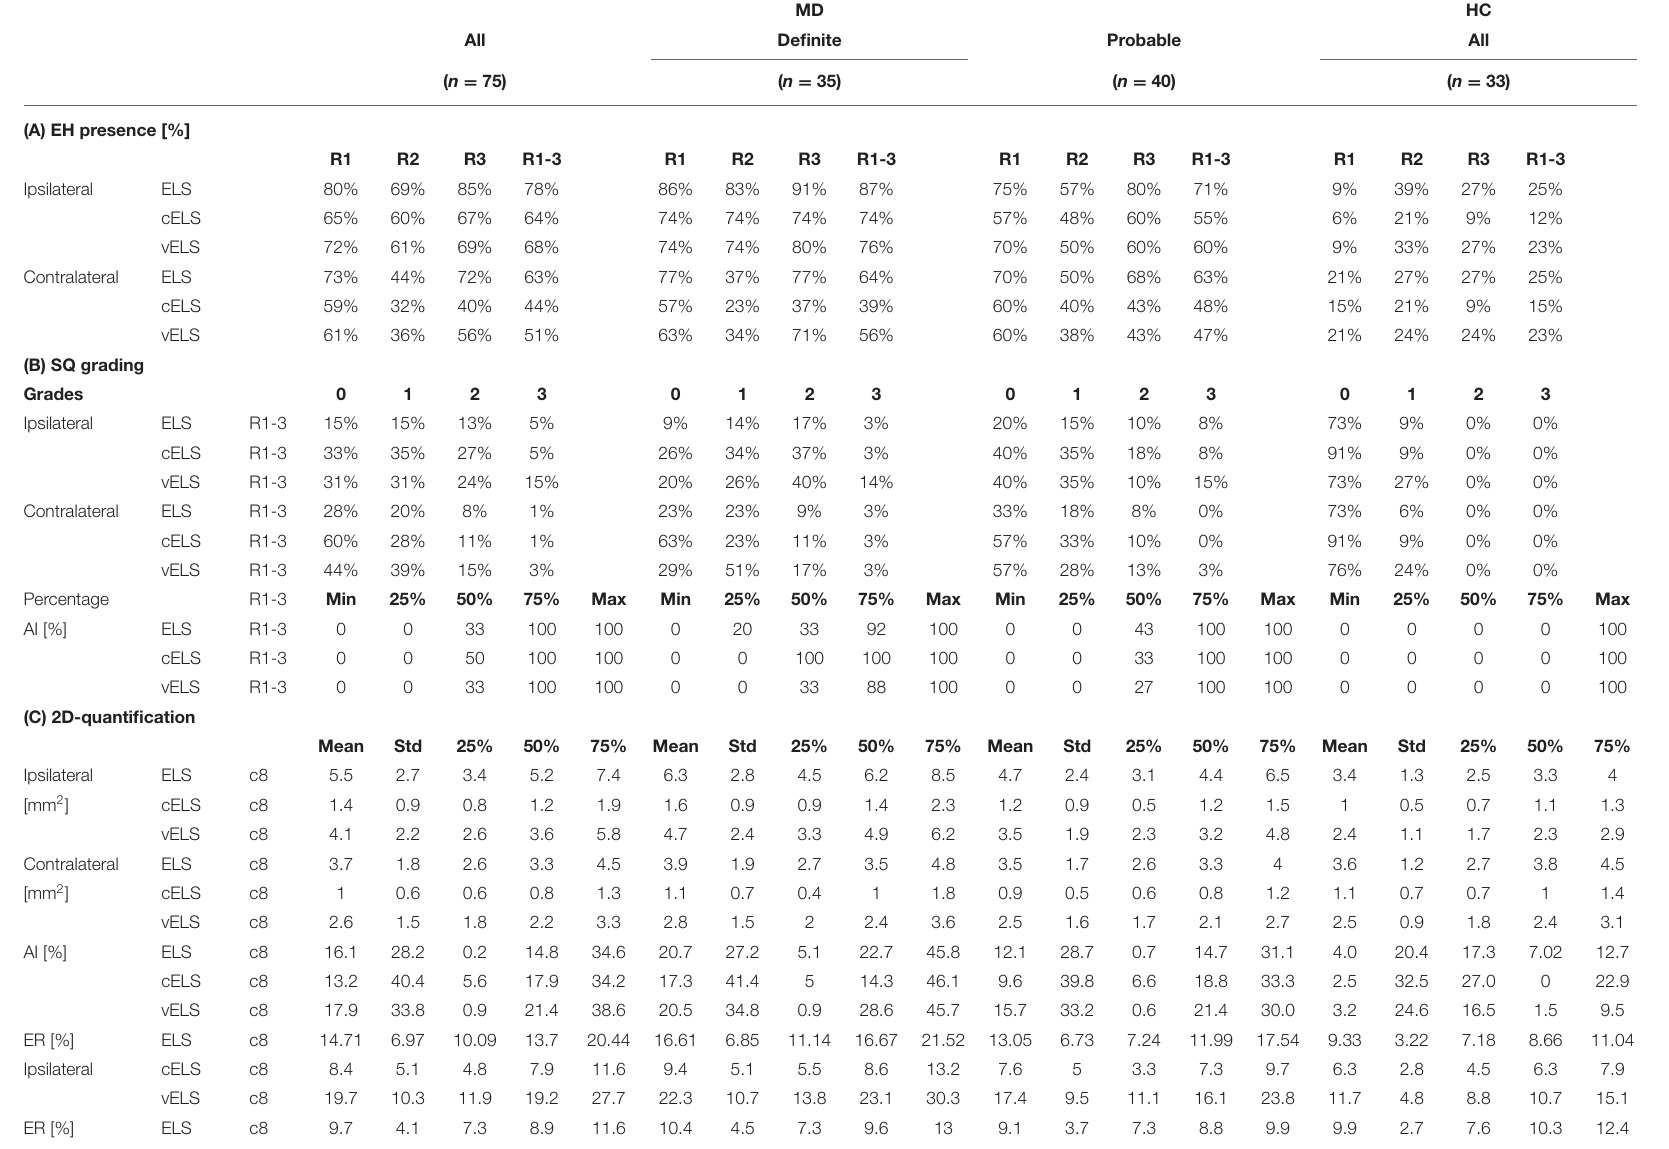
TABLE 3 | Semi-quantitative (SQ) grading, 2D- and 3D-quantification of the